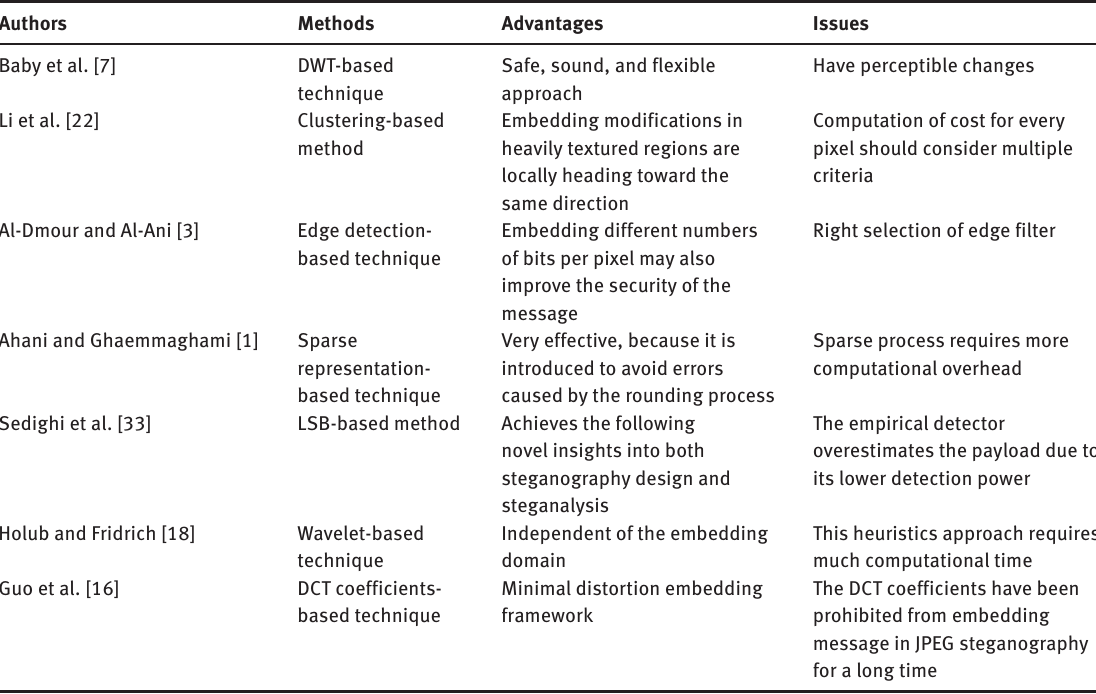
Table 1: Literature Review. Authors